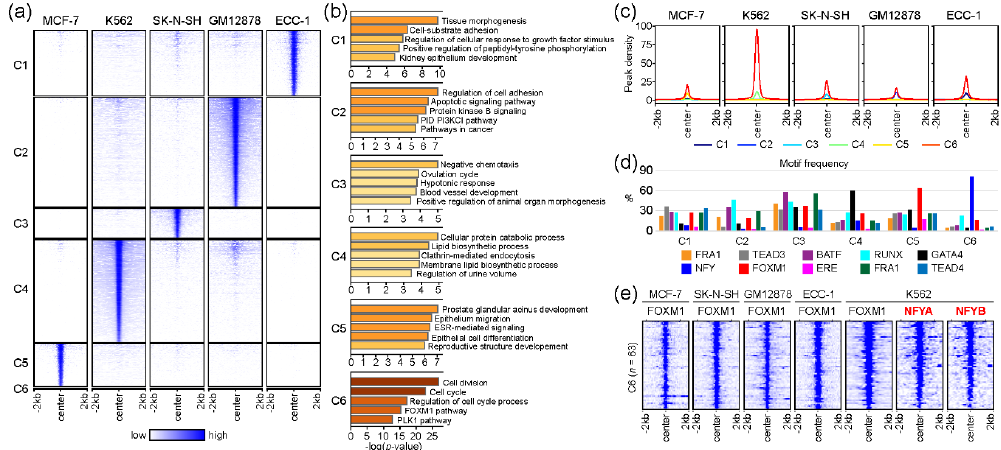
Figure 3. Comparative analysis of FOXM1 binding sites between cell lines. ( a ) The heatmap shows common (C6) and unique (C1–C5) clusters of FOXM1 binding sites between MCF-7, K562, SK-N-SH, GM12878, and ECC-1 cell lines. ( b ) Gene ontology (GO) analysis was performed using Metascape with the top 500 genes (ranked by the height of FOXM1 peaks) around the FOXM1 binding sites in each cluster. ( c ) The line plots show the average of the FOXM1 peak signal at the FOXM1 binding sites. ( d ) The bar plot shows the frequency of motif counts found at the FOXM1 binding sites of the clusters. ( e ) The heatmap shows binding profiles of given transcription factors on FOXM1 binding sites in the C6 cluster. NFYA and NFYB ChIP-seq were reanalyzed from a previous study (GSE26439) [29].